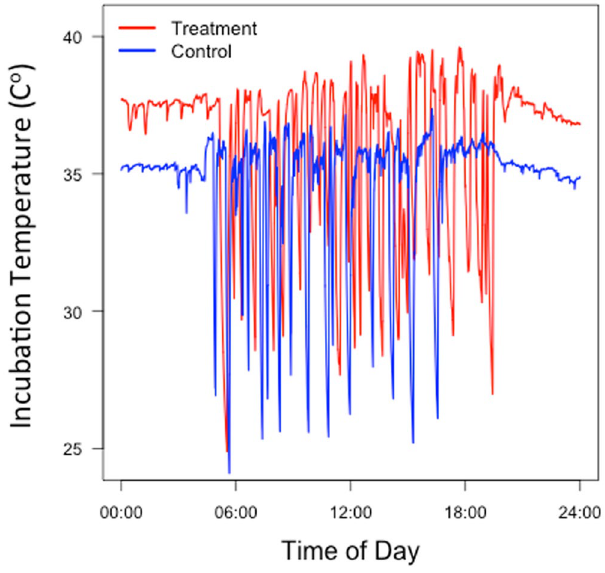
Figure 4. Thermal conditions experienced during 24 hours of incubation by a control and a treatment clutch of Red-faced warblers ( Cardellina rubifrons ) of the same age. Measurements were recorded on the same date and nesting habitat; temperature oscillations reflect parental incubation behavior, with downward spikes from parents leaving the nest to